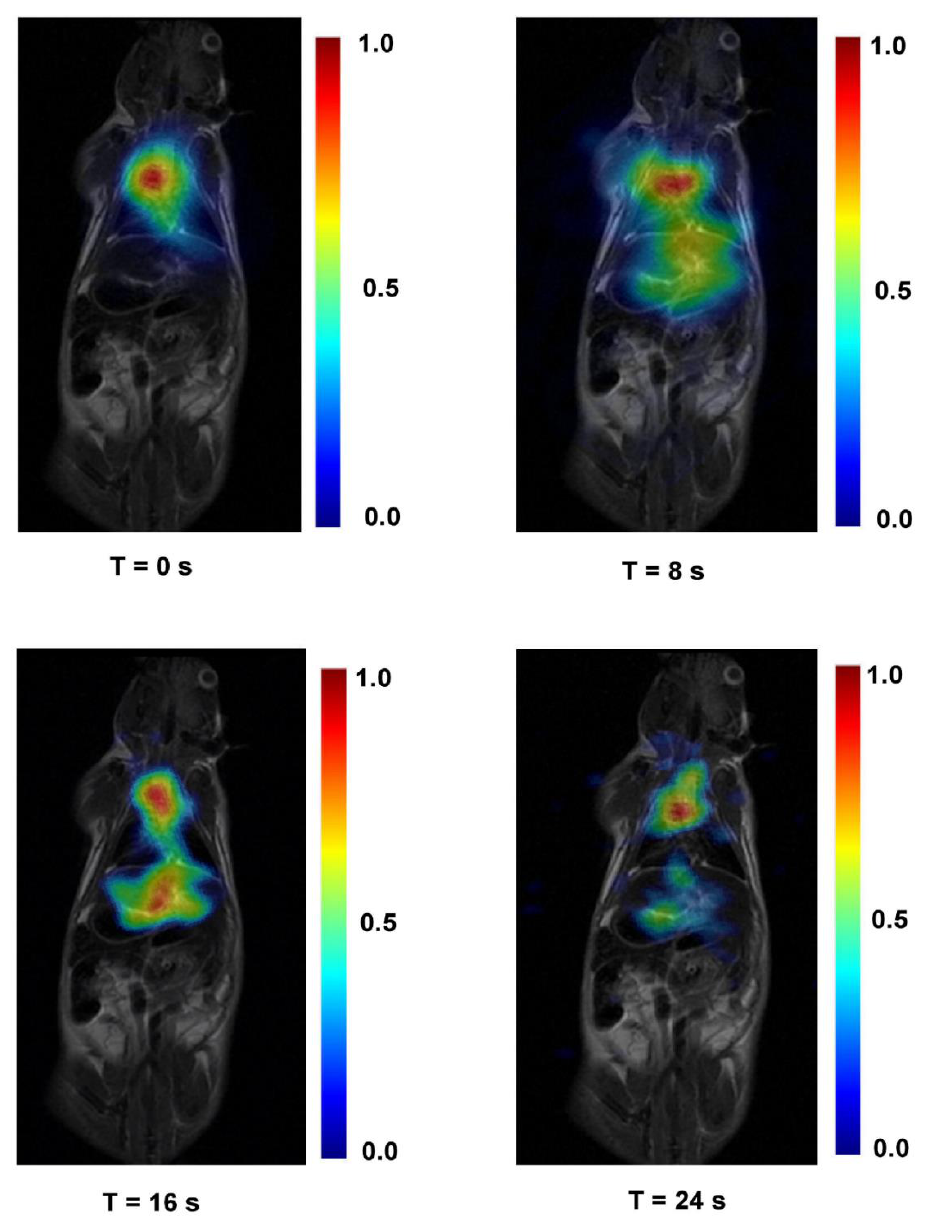
Figure 14. Metabolic maps of spatial distribution of hyperpolarized [1- 13 C]pyruvate obtained in vivo and in real time with a time step of 8 s, overlapped on reference anatomical images. Reprinted from Scanning 2016 [69].